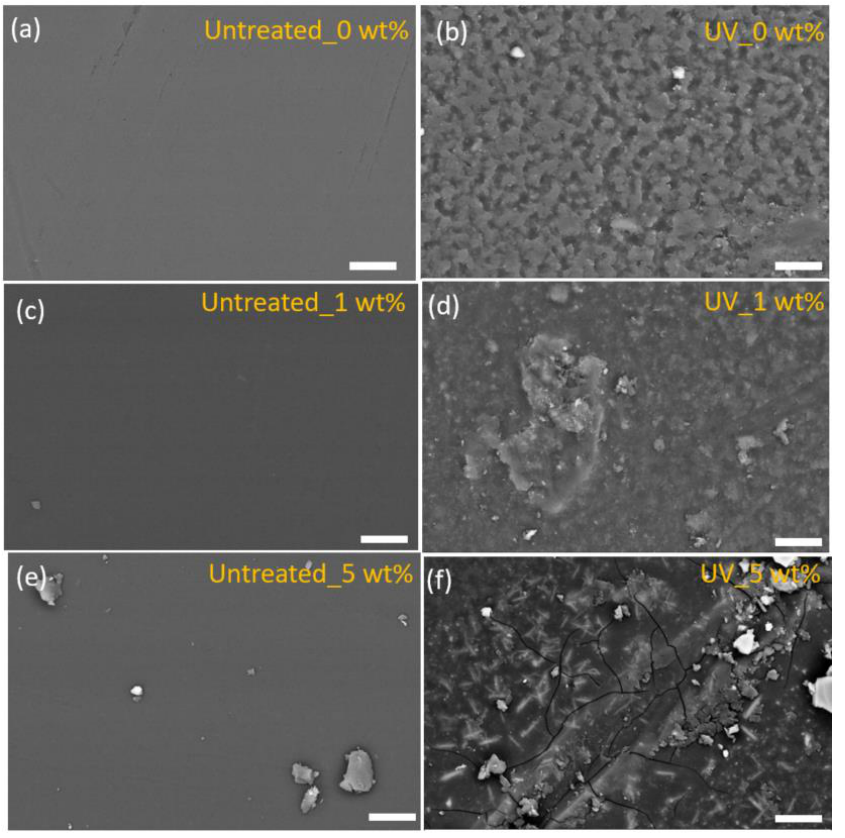
Figure 4. Surface SEM images of untreated samples: ( a ) 0 wt.%, ( c ) 1 wt.%, and ( e ) 5 wt.% NPs, and after UV exposure: ( b ) 0 wt.%, ( d ) 1 wt.%, and ( f ) 5 wt.% NPs. Scale bar: 10 µm.